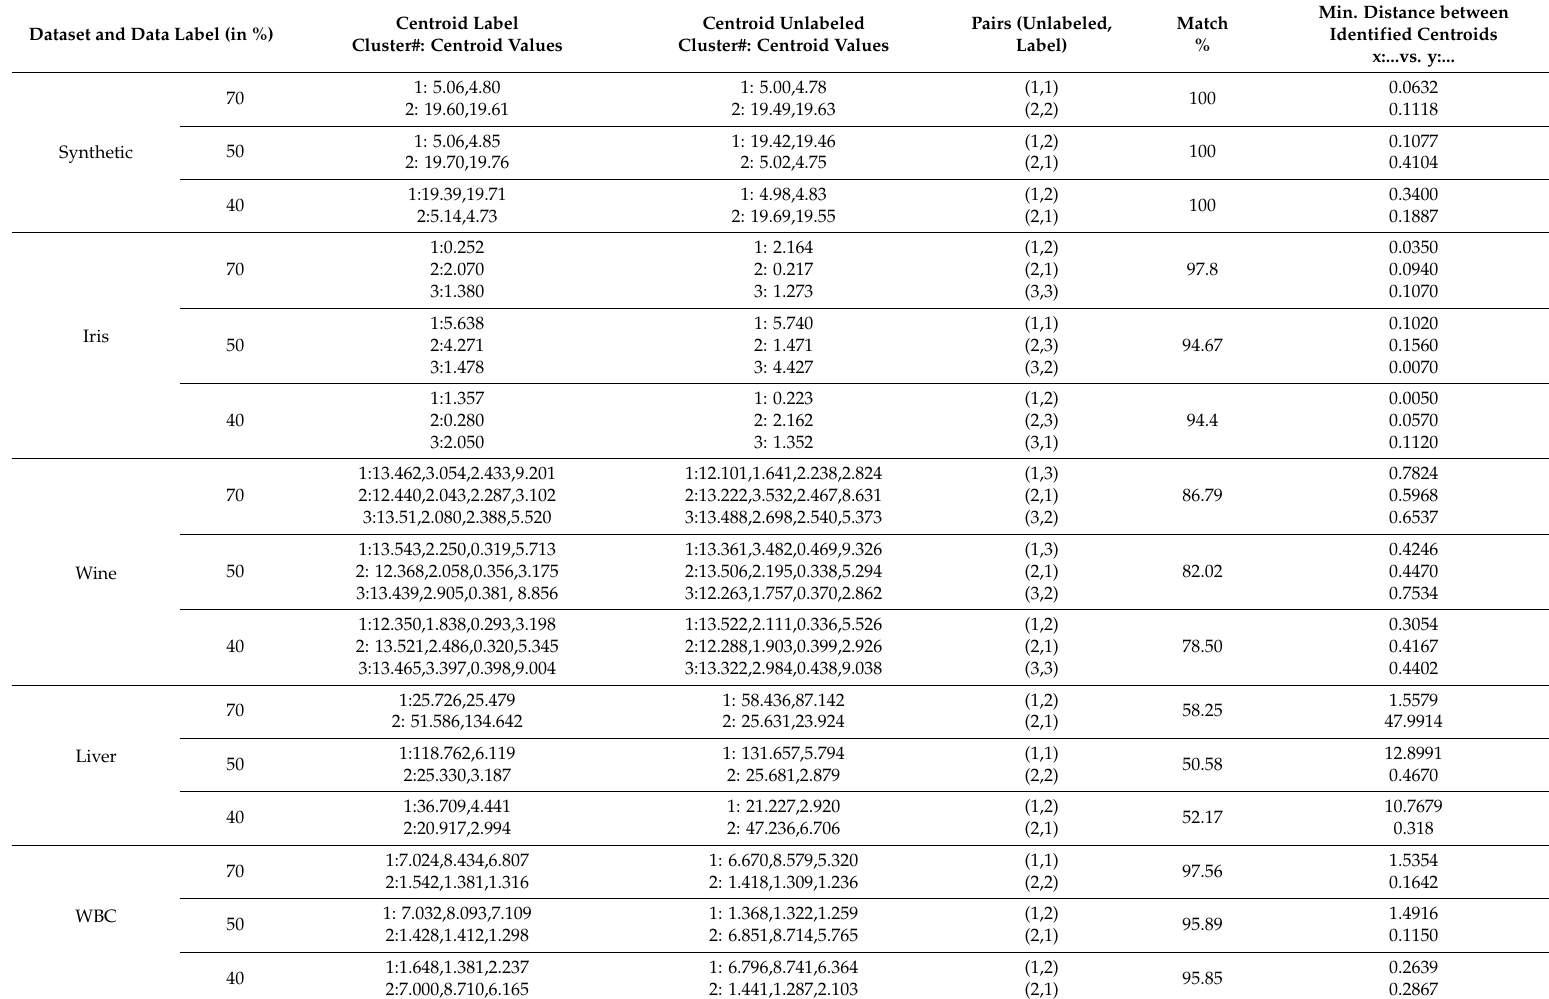
Table 7. Pairing of cluster centroids between labeled and unlabeled datasets. Dataset and Data Label (in